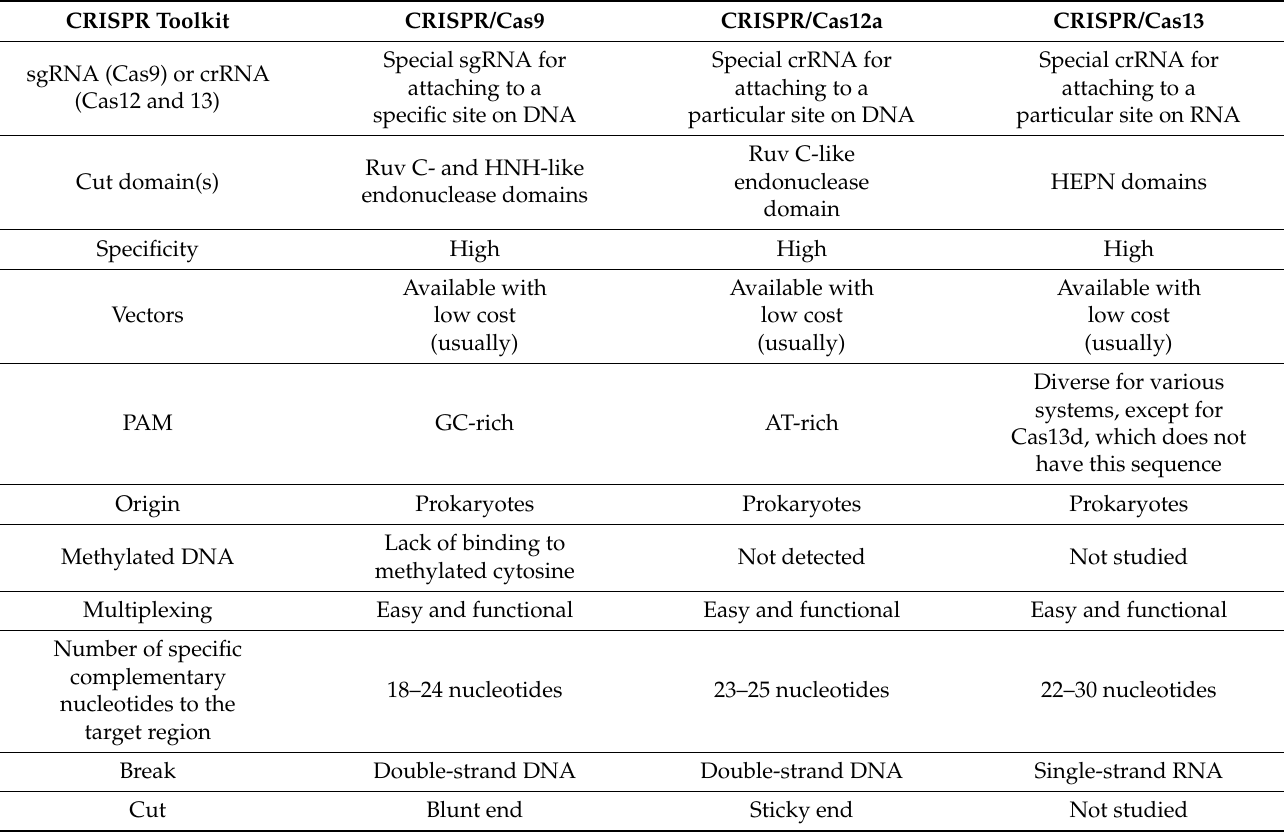
Table 1. Comparison of the CRISPR/Cas9, CRISPR/Cas12, and CRISPR/Cas13 toolkits